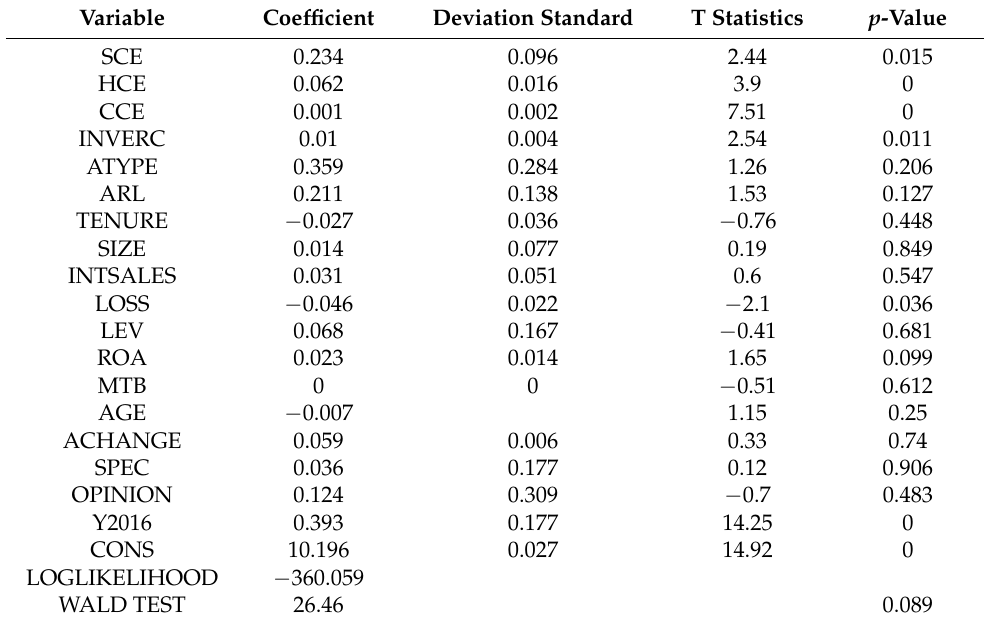
Table 12. The results of estimating the third model by the FGLS